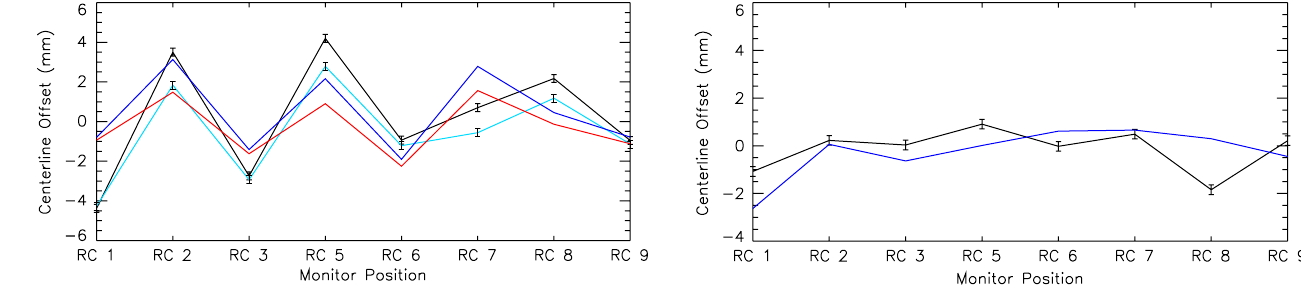
FIG. 16. (Color) The blue line is the predicted value for the new steering settings, while the black line is the measured trajectory.